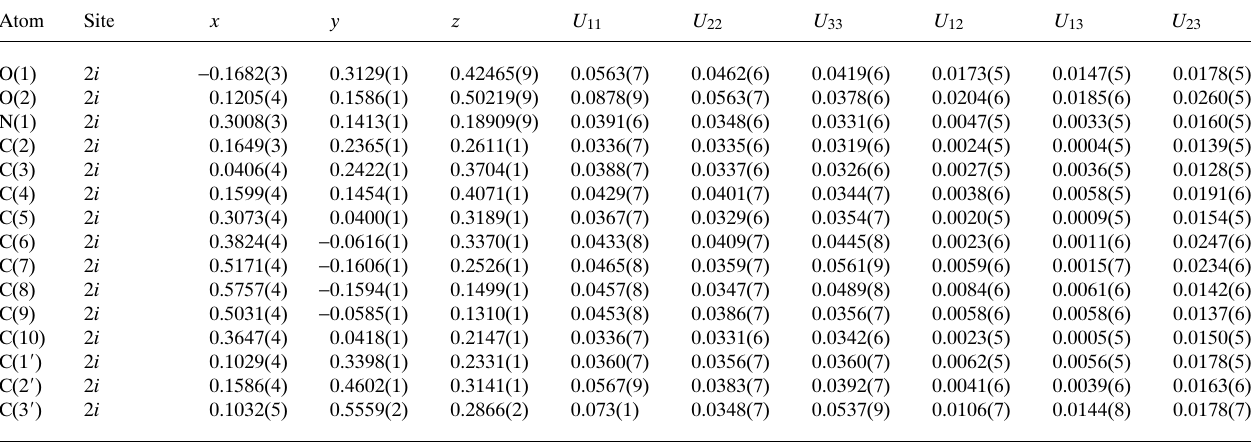
Table 3. Atomic coordinates and displacement parameters (in Å 2 )